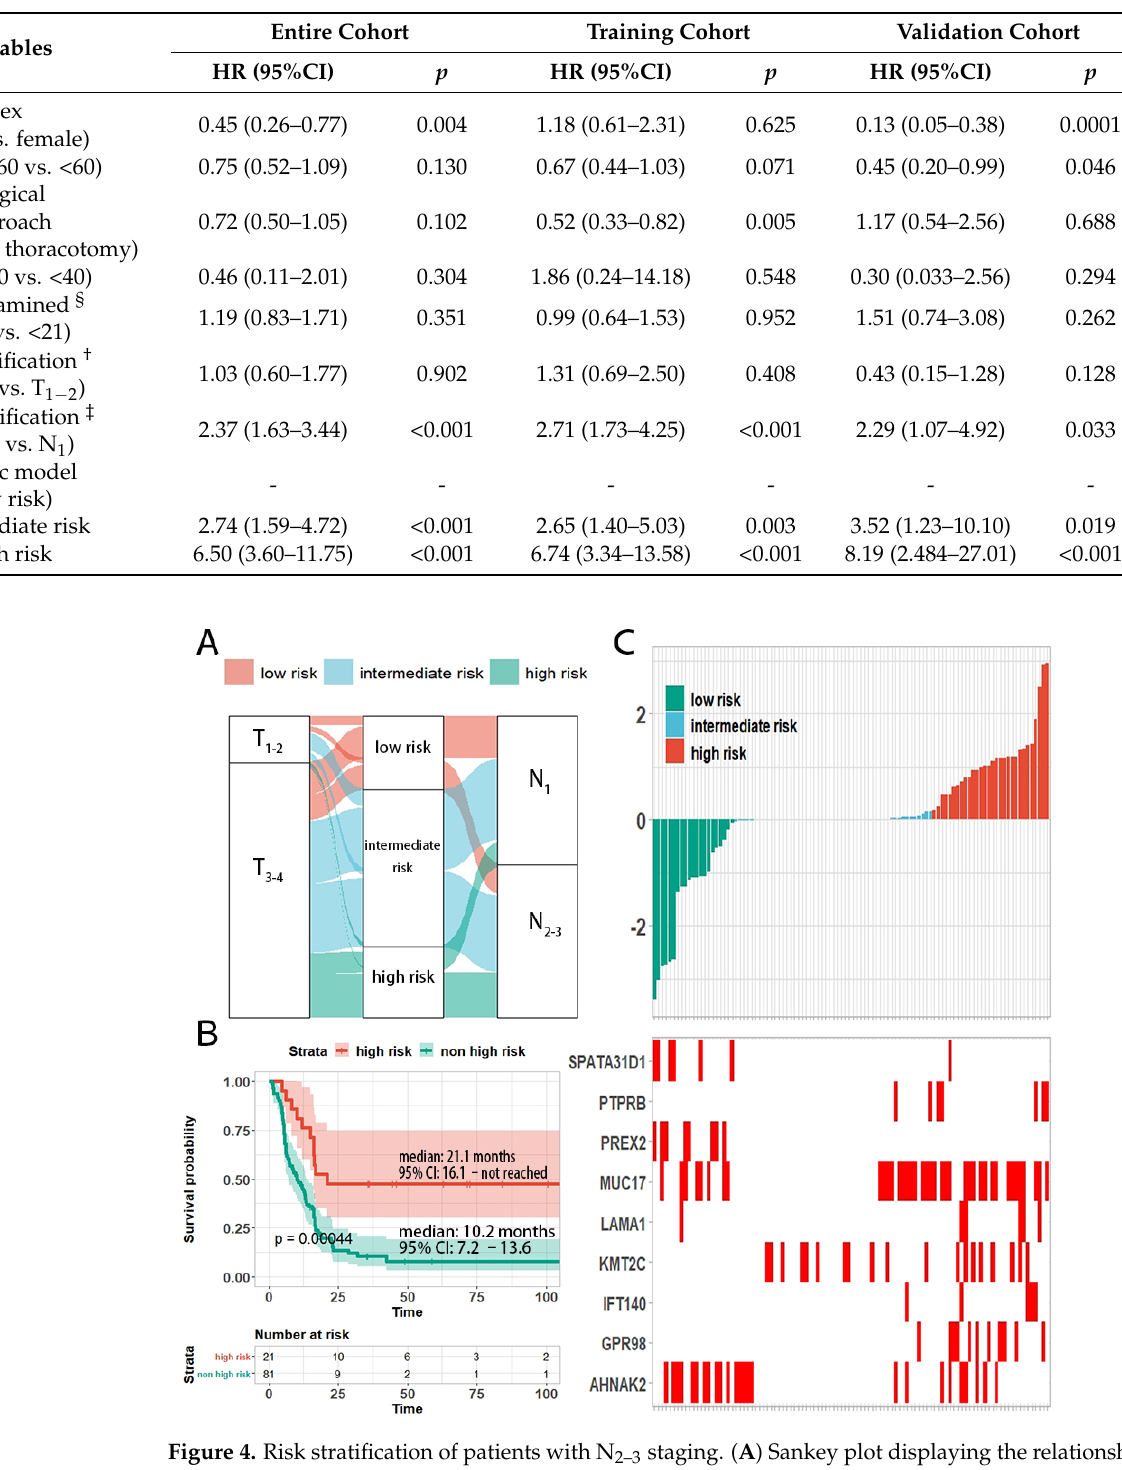
Table 2. Multivariate Cox regression of the eight-gene-based predictor and clinicopathological factors. †: pathological T classification. ‡: pathological LN classification. §: stratified by median of variables.